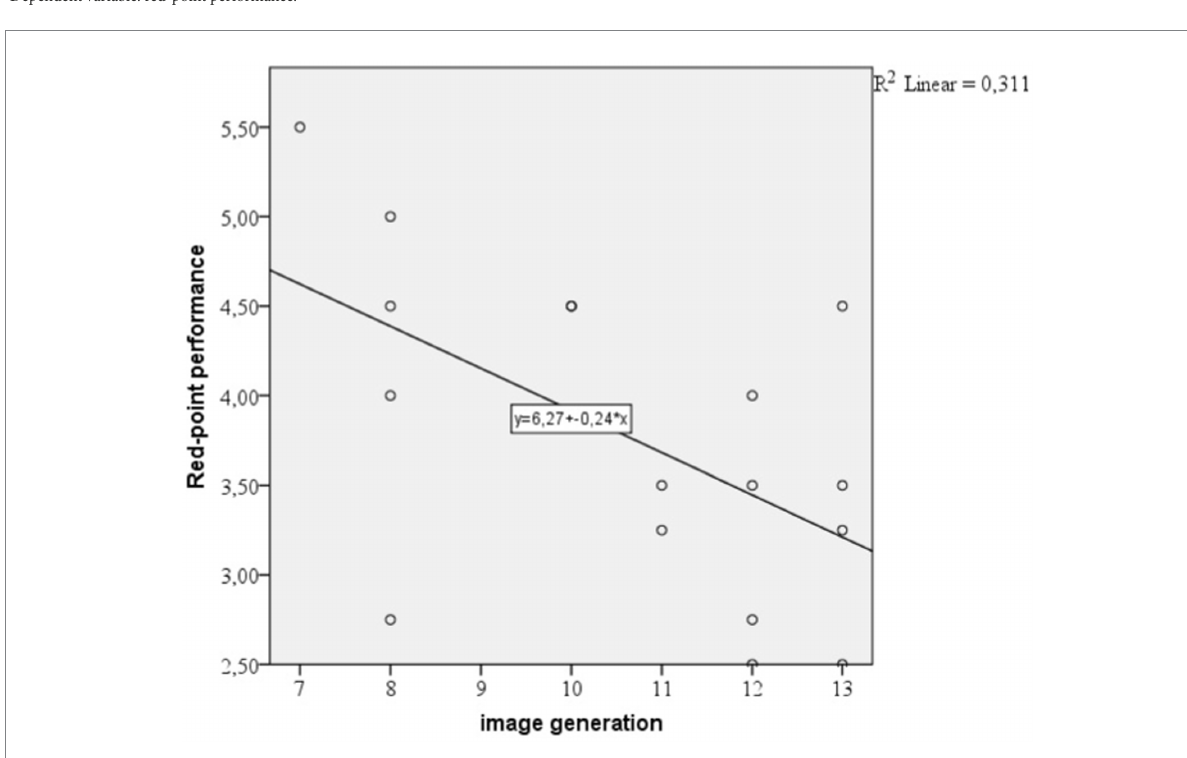
FIGURE 5 Scatterplot explaining simple linear regression between image generation and red point performance.